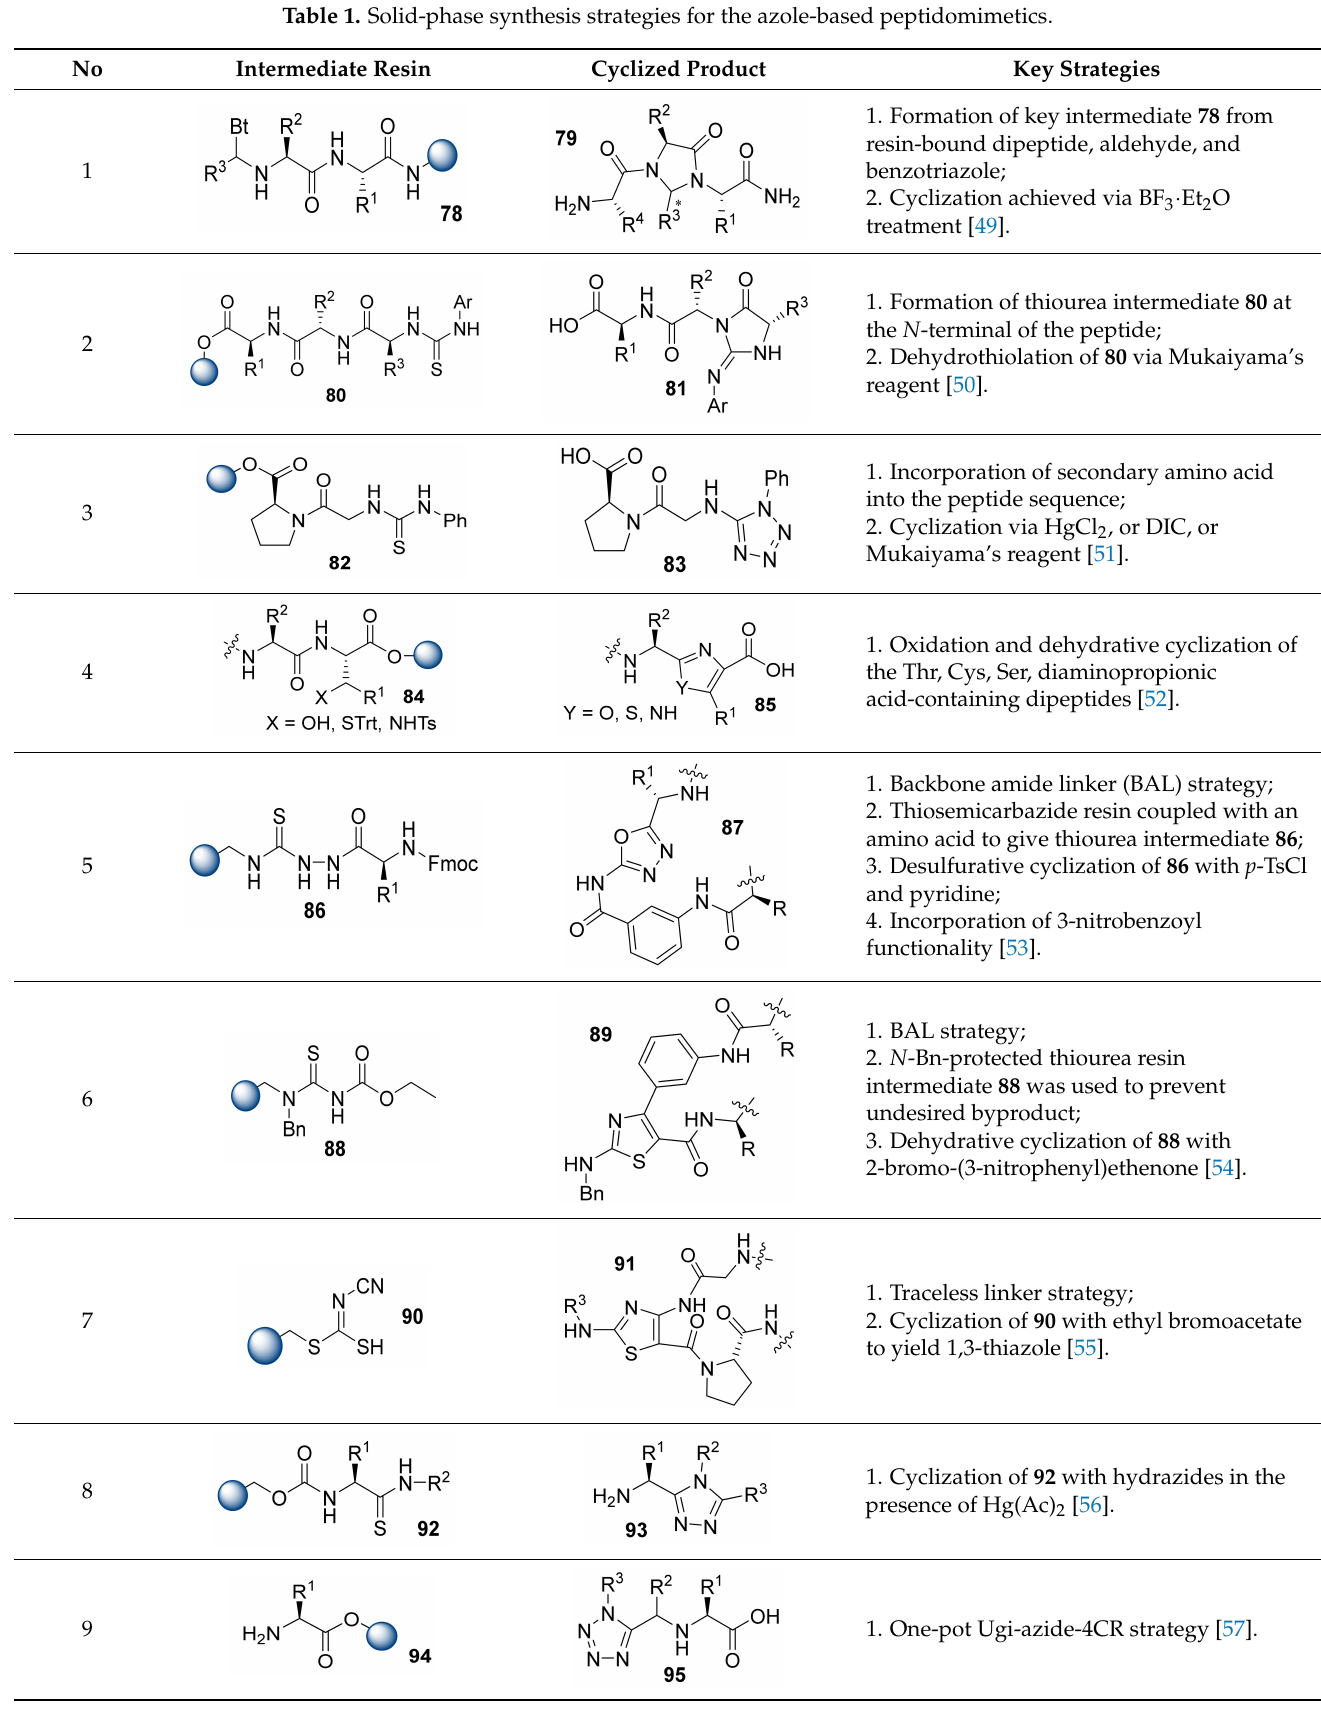
Table 1. Solid-phase synthesis strategies for the azole-based